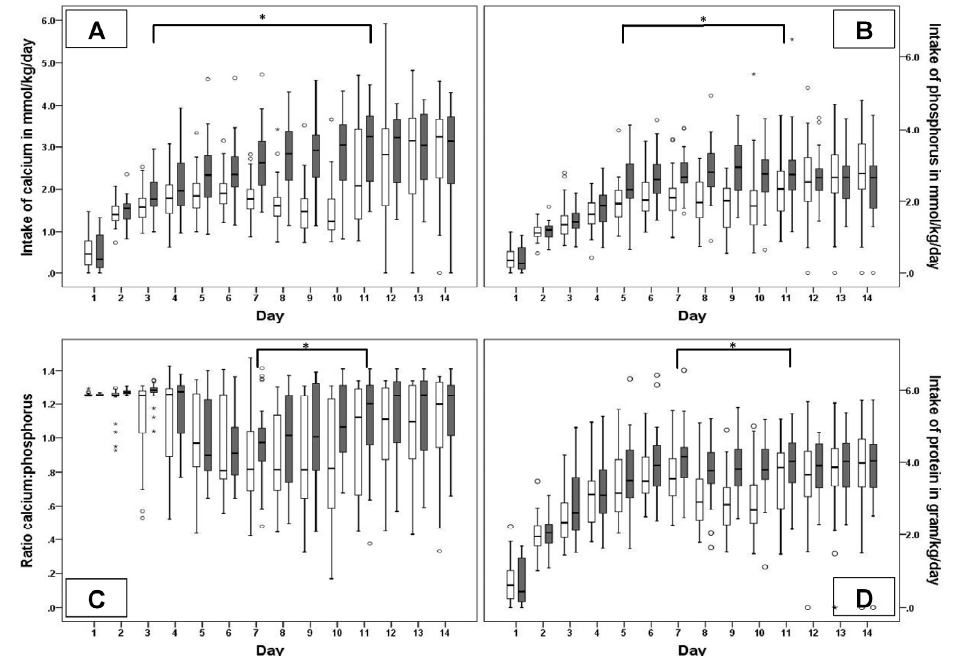
Figure 2. Nutritional intake during the first 14 days: white bars: Low; black bars: High; The horizontal black bars with * indicate the days on which the intake was statistically significant different. ( A ) Daily intake of calcium in mmol/kg/day; * = p < 0.05; ( B ) daily intake of phosphorus in mmol/kg/day; * = p < 0.05; ( C ) daily intake of protein in gram/kg/day; * = p < 0.05; and ( D ) ratio calcium intake to phosphorus intake; * = p < 0.05 Data are presented as median, interquartile range and upper and lower limits.